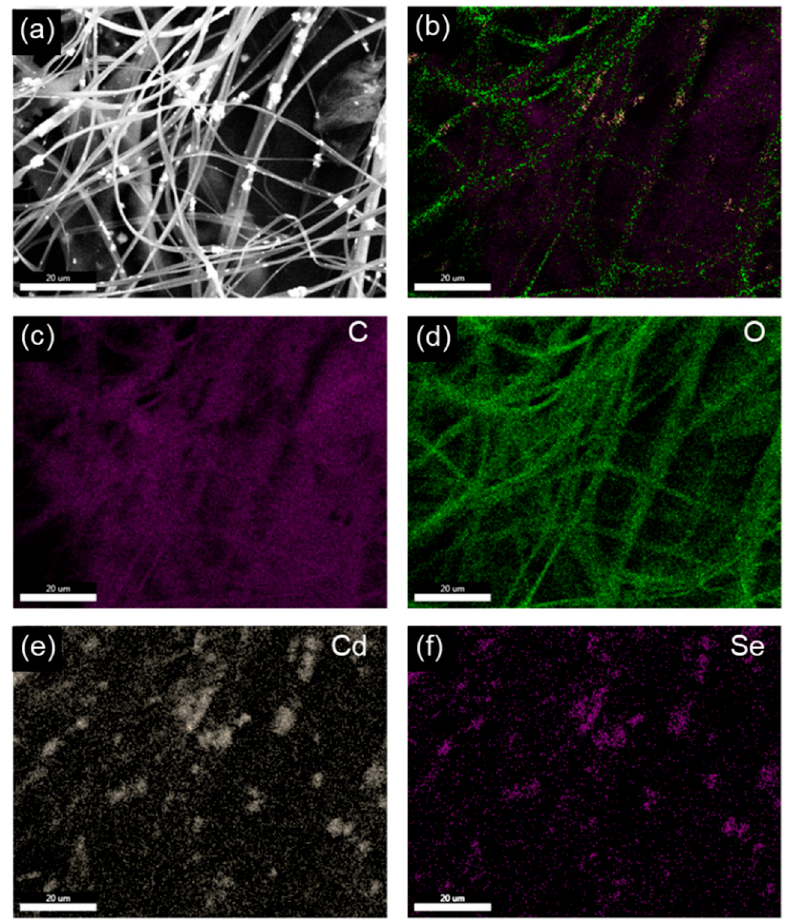
Figure 2. ( a ) FESEM, ( b ) overall elemental distribution, and ( c – f ) C, O, Cd, and Se elemental distribution of CdSe-CA (1:1) fibers obtained using energy dispersive X-ray spectrometry (EDS) mapping.